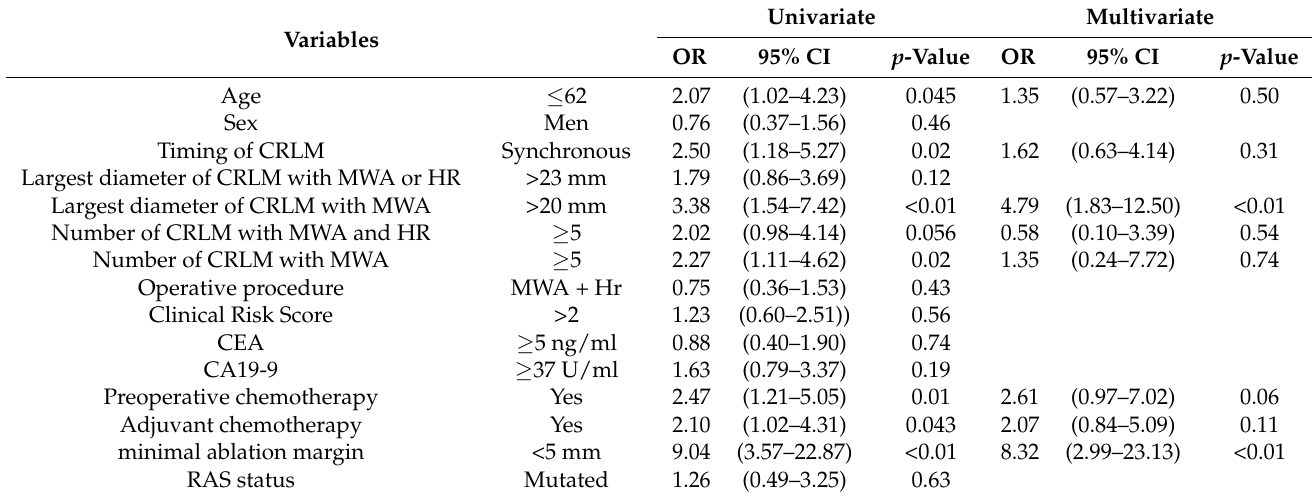
Table 2. Univariate and multivariate analysis of predictive factors for local recurrence in CRLM patients following treatment with